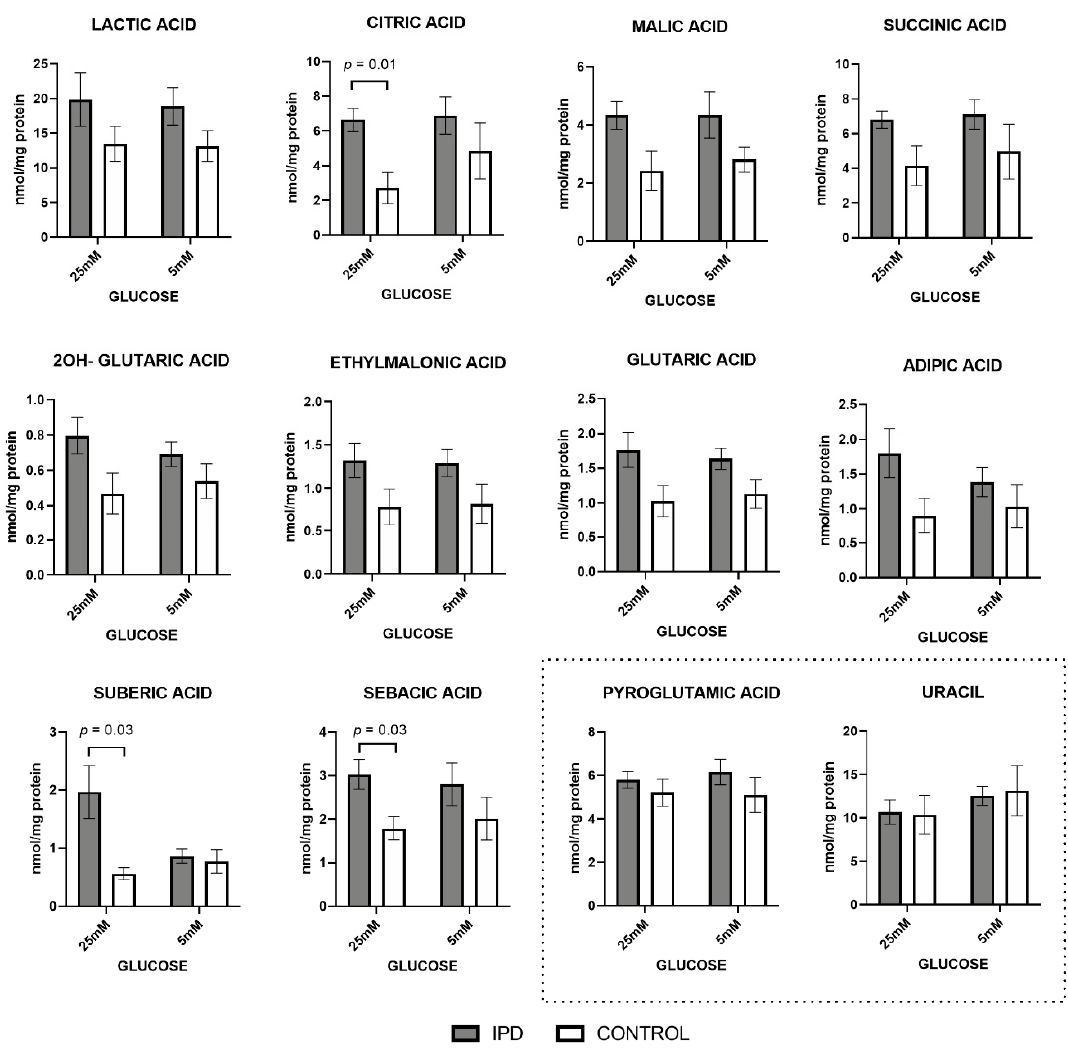
Figure 1. Organic acid levels in fibroblasts of idiopathic Parkinson’s disease (iPD) patients vs. controls exposed to low or high glucose concentration (5 vs. 25 mM). Levels of organic acids related to mitochondrial metabolism were increased in fibroblasts from idiopathic Parkinson’s disease patients (iPD, grey bars) vs. controls (C, white bars), especially in high glucose (25 mM) exposition. As technical controls, the levels of nucleotides and organic acids non-related to mitochondrial energy metabolism (including uracil and pyroglutamic acid) were measured and found to be conserved among patients, controls, and glucose conditions, suggesting that only mitochondrial-related organic acids were affected.